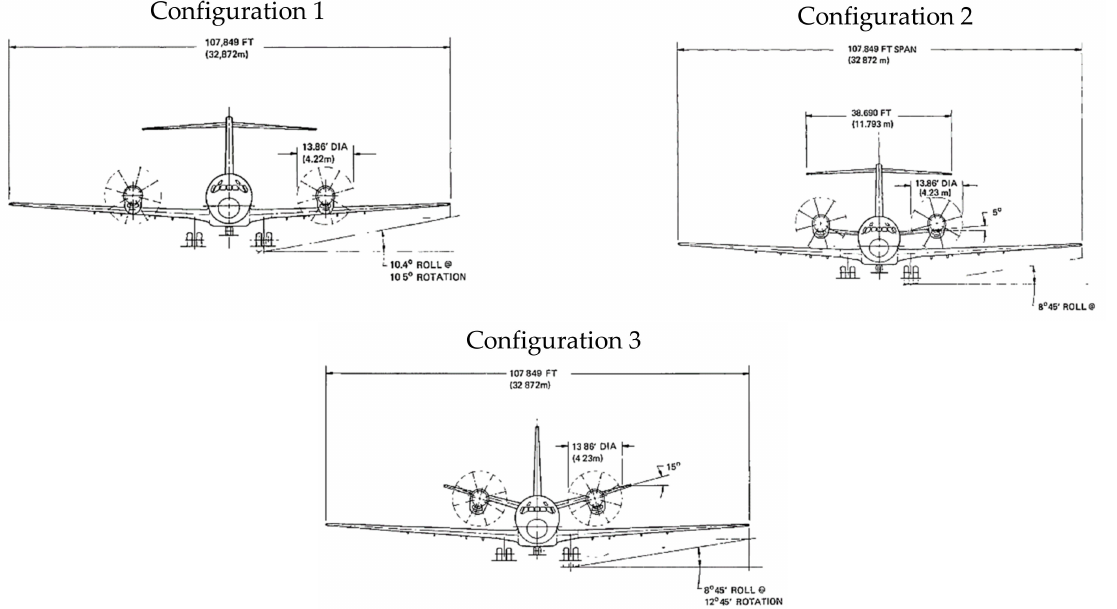
Figure 3. Configuration selected by the NASA feasibility study. Reprinted from ref.